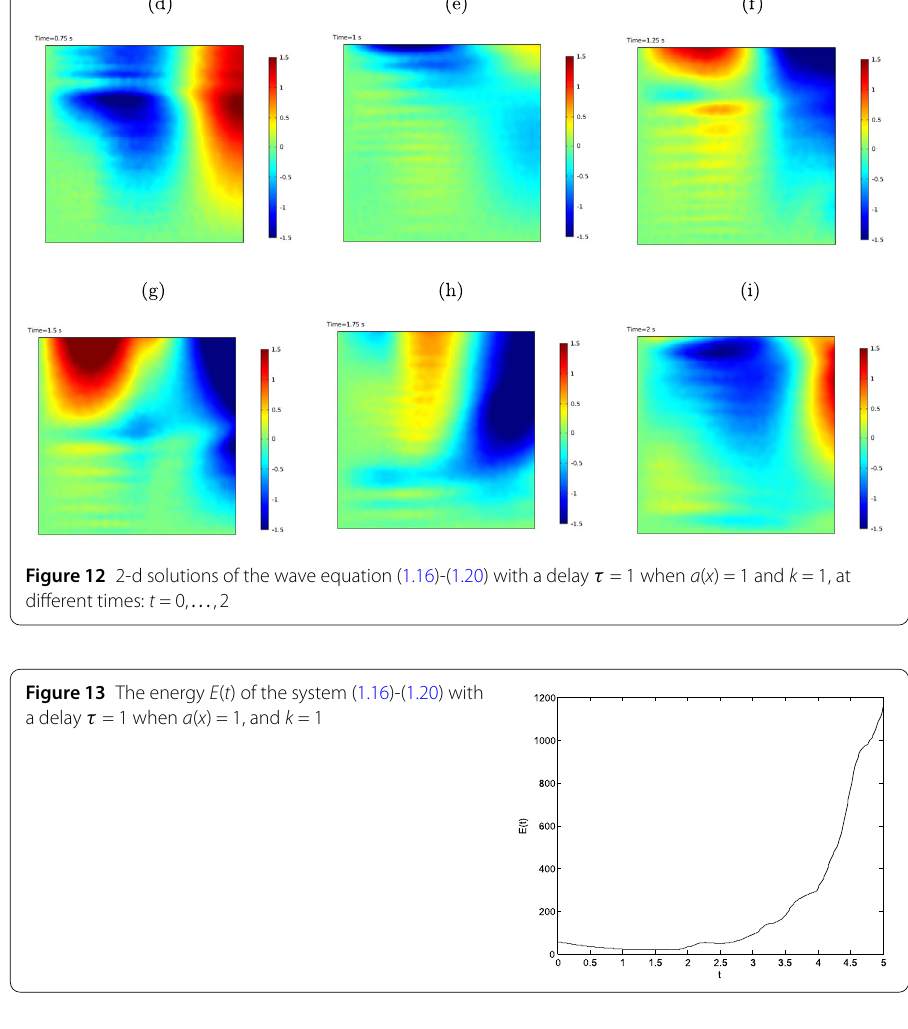
is in the sense of Y ) such that (cid:14) P (cid:14) h , P ϕ (cid:15) ϕ (cid:15) Y –1 , Y 1 = Y –1 h ,